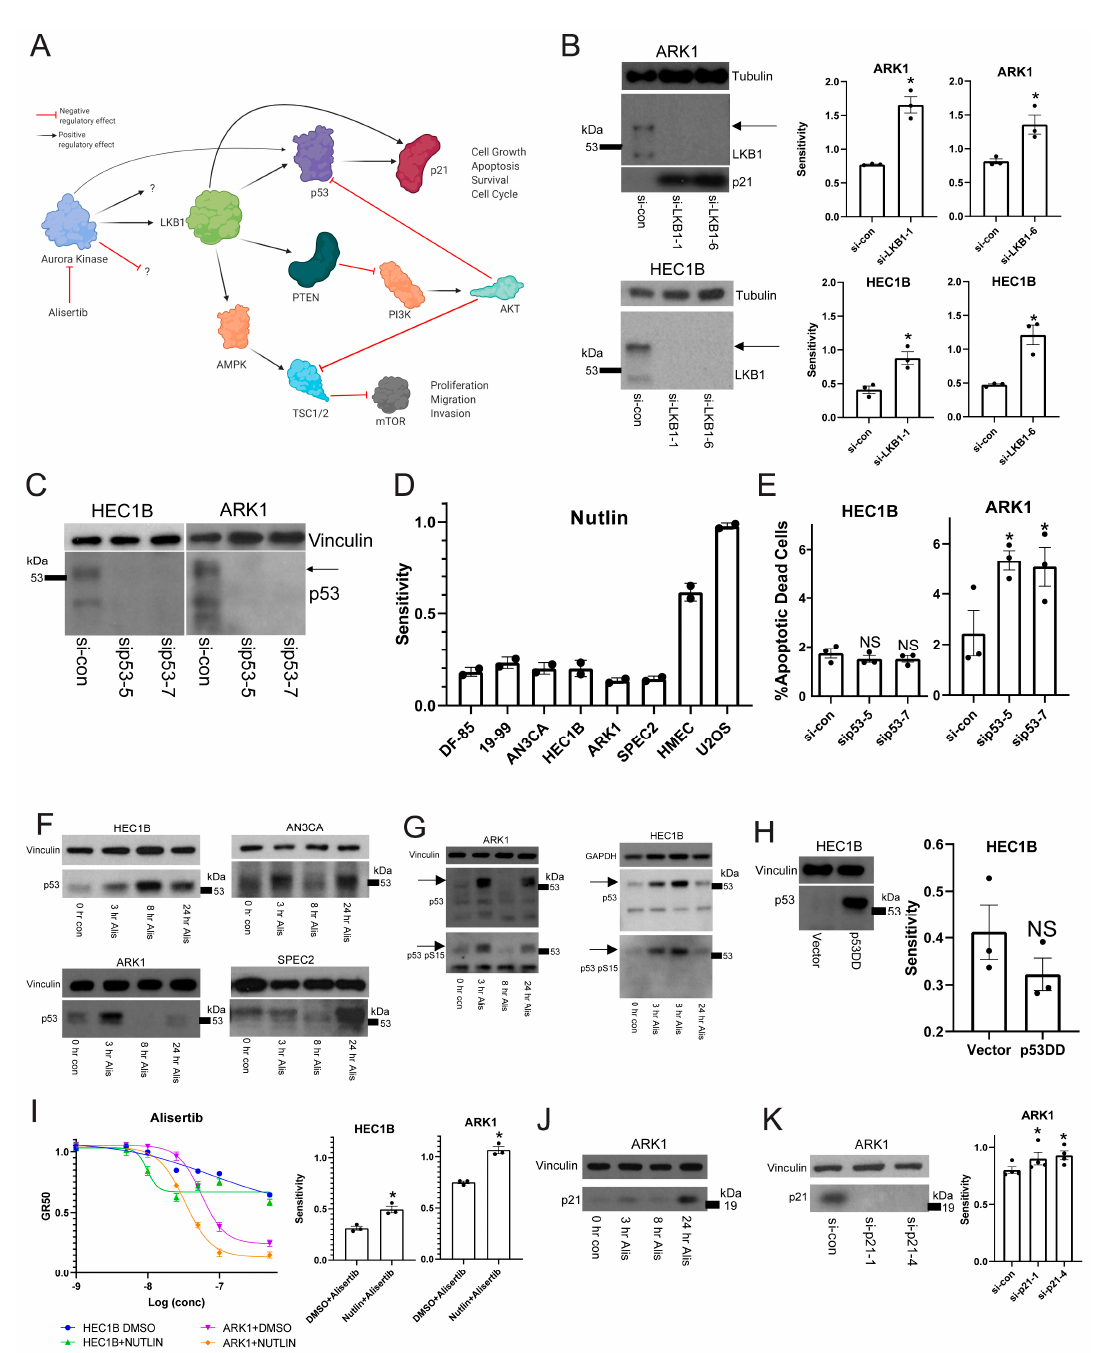
Figure 3. Aurora kinase inhibitor cytotoxicity is mediated in part through the function of mutant p53 and LKB1 signal- ing. ( A ) A cartoon demonstrating how Aurora kinase is linked to both the p53/p21 and PI3K/AKT arms of LKB1 kinase signaling. ( B ) ARK1 and HEC1B cells were transfected with either a control siRNA (si-con) or one of two LKB1 specific siRNAs (si-LKB1-1 or si-LKB1-6) and then treated with a dose range of Alisertib. Western blots showing LKB1 depletion, and p21 upregulation in the case of ARK1, are shown on the left. Two bands were detected, and the top band indicated by an arrow represents the phosphorylated form. Sensitivities (area over the growth rate corrected dose curve) are shown on the right for each cell line with each siRNA. Bars represent the average of three replicates, and error bars represent standard error of the mean. p -values were calculated using a paired t -test. * p < 0.05. ( C ) Western blots demonstrating p53 depletion in HEC1B and ARK1 with two p53 specific siRNAs (sip53-5 and sip53-7) compared to a control. Two isoforms of p53 are detected, but the top isoform running at 53kDa indicated by an arrow here represents the full length p53 changing with treatment